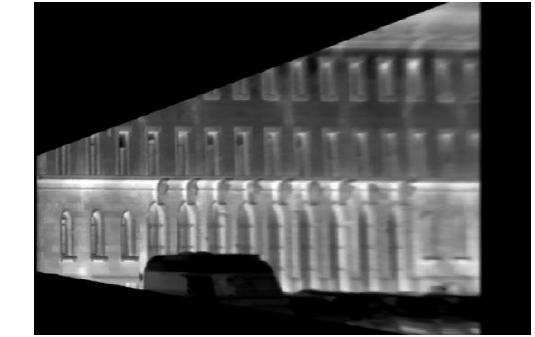
Figure 6. Partial texture of one façade extracted from one IR image